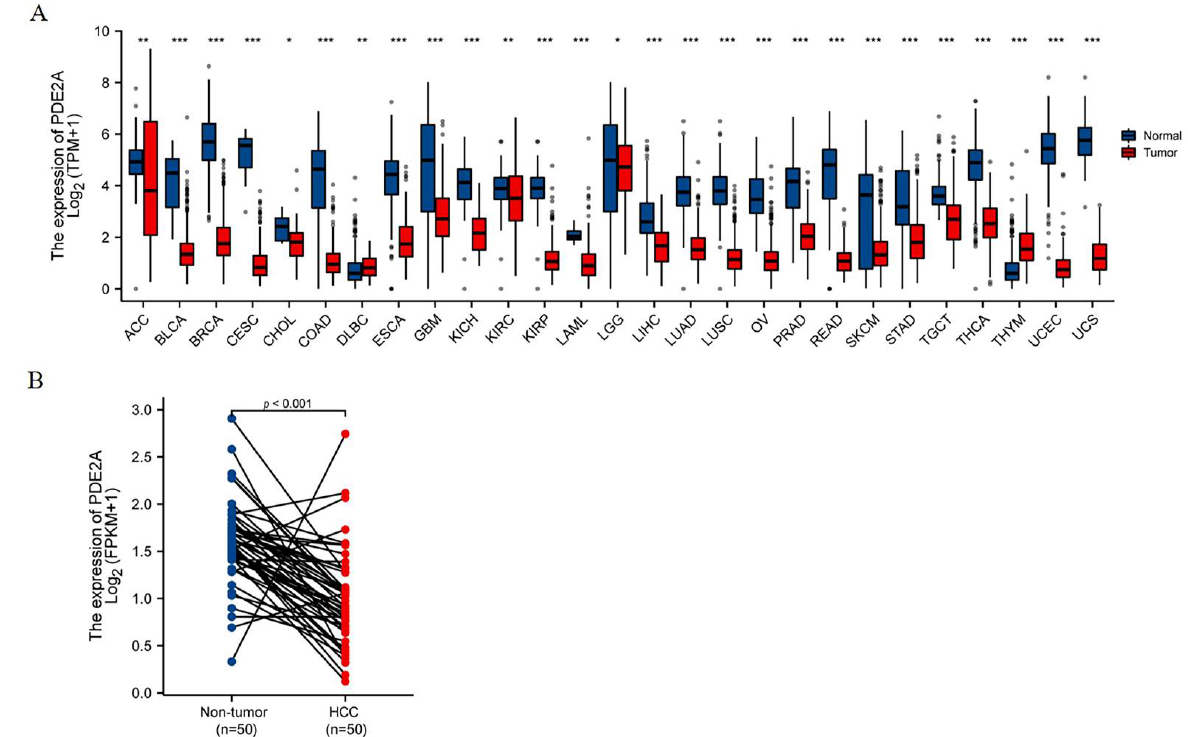
Figure 1. PDE2A mRNA expression profiles. ( A ) Pan-cancer analysis of PDE2A mRNA expression based on TCGA database. ns, p ≥ 0.05; * p < 0.05; ** p < 0.01; *** p < 0.001. ( B ) The comparison of PDE2A expression between HCC and para cancer non-tumor tissue in paired HCC samples. ACC: Adreno- cortical Cancer; BLCA: Bladder Cancer; BRCA: Breast Cancer; CESC: Cervical Cancer; CHOL: Bile Duct Cancer; COAD: Colon Cancer; DLBC: Large B-cell Lymphoma; ESCA: Esophageal Cancer; GBM: Glioblastoma; KICH: Kidney Chromophobe; KIRC: Kidney Clear Cell Carcinoma; KIRP: